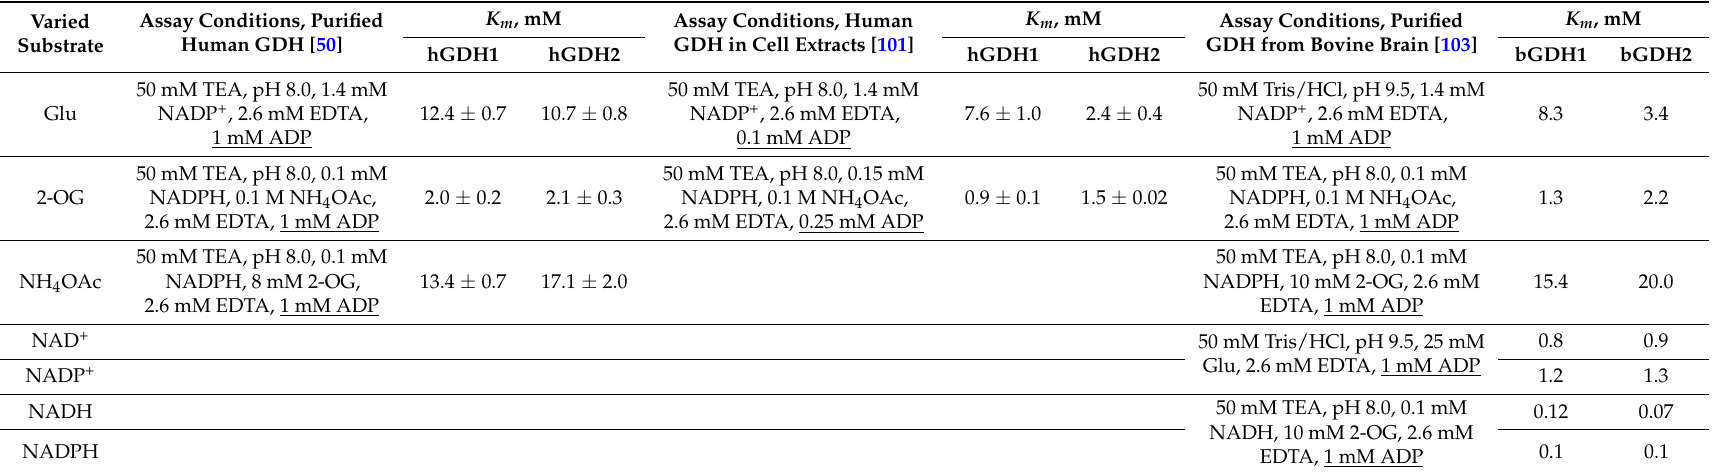
Table 3. Comparison of kinetic parameters of the overexpressed human GDH isoenzymes, either purified [50] or in cell extracts [101], and the multiple forms of GDH from bovine brain [103]. TEA—triethanolamine, NH 4 OAc—ammonium acetate, 2-OG—2-oxoglutarate, Glu—glutamate. The ADP concentrations (in bold) are important to note when comparing the differences in K m , exhibited by the GDH